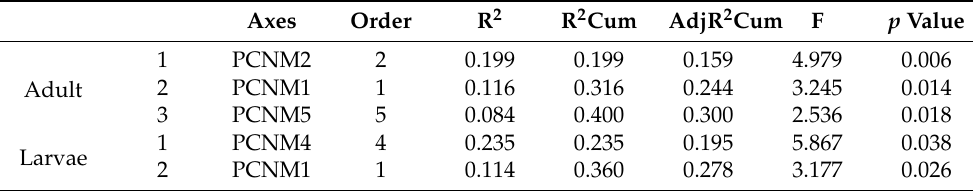
Table 1. PCNM axes of spatial predictors selected by the forward selection model for adult and larvae among the streams in cocoa areas in the southern region of the state of Bahia. Axes Order R